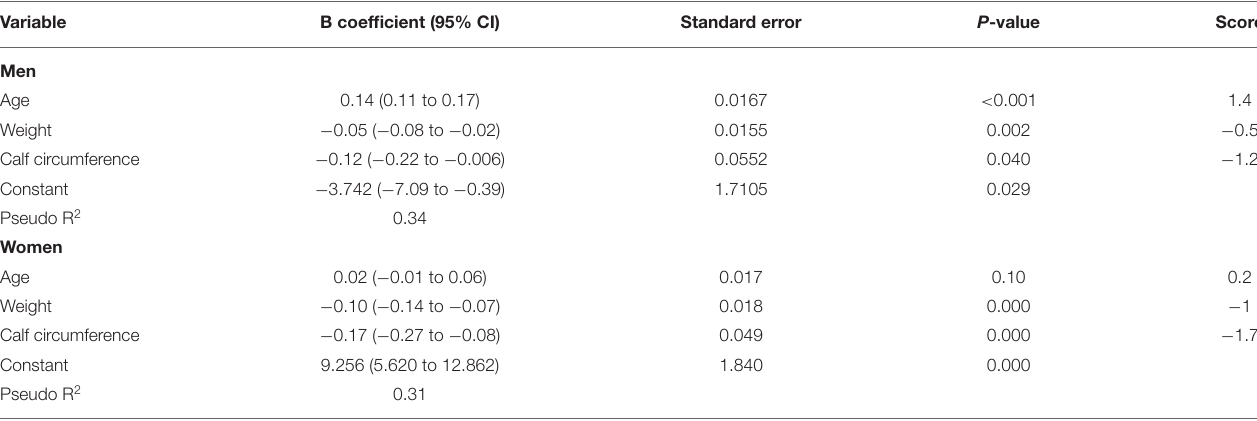
TABLE 2 | The results of the multivariate analysis and the development scoring system in development